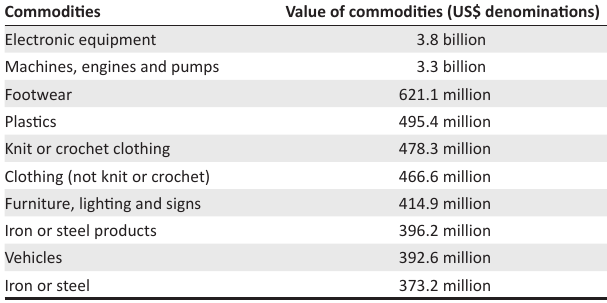
TABLE 1: South Africa top 10 exports to China.